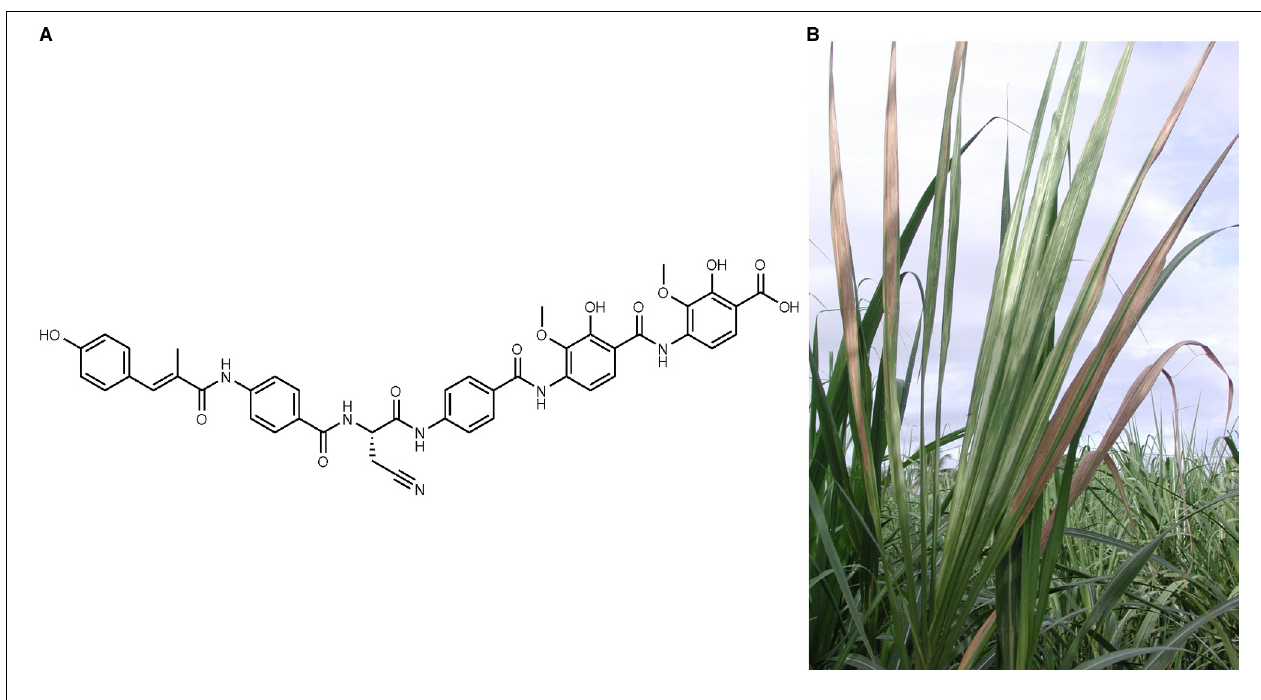
FIGURE 1 | Xanthomonas albilineans produces the phytotoxin albicidin—a potent gyrase inhibitor that blocks chloroplast differentiation, resulting in sugarcane leaf scald disease symptoms. (A) Structure of albicidin, a hybrid PKS/NRPS compound